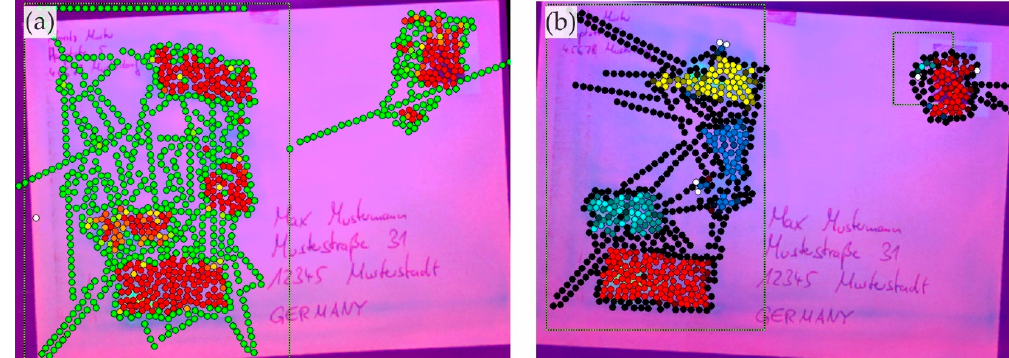
Figure 13. Two examples of the visualization possibilities. ( a ) Detection indication from green (no substance of database identified) over yellow/orange (uncertain result) to red (positive identification of a substance in the database). ( b ) Depending on the specific substance identified at the point of measurement, a color code is used, enabling the discrimination of substances. From black (no detection) to dark color (low similarity) to color (strong similarity).